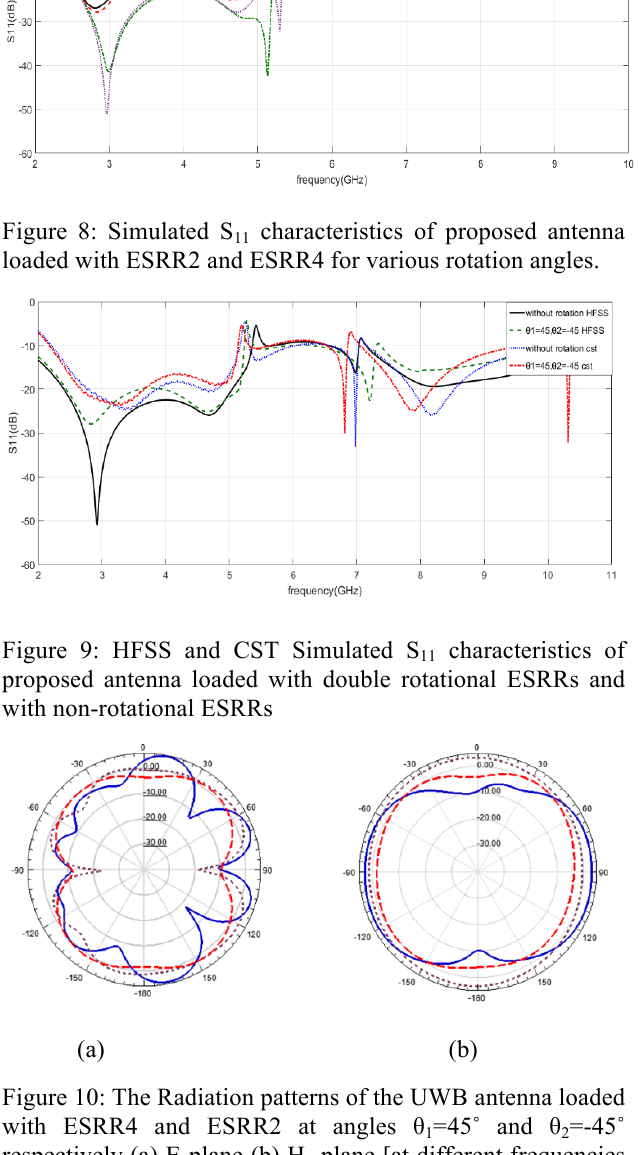
Figure 10: The Radiation patterns of the UWB antenna loaded with ESRR4 and ESRR2 at angles θ respectively (a) E-plane (b) H- plane [at different frequencies 4GHz (long dashes), 6GHz (short dashes), and 10GHz